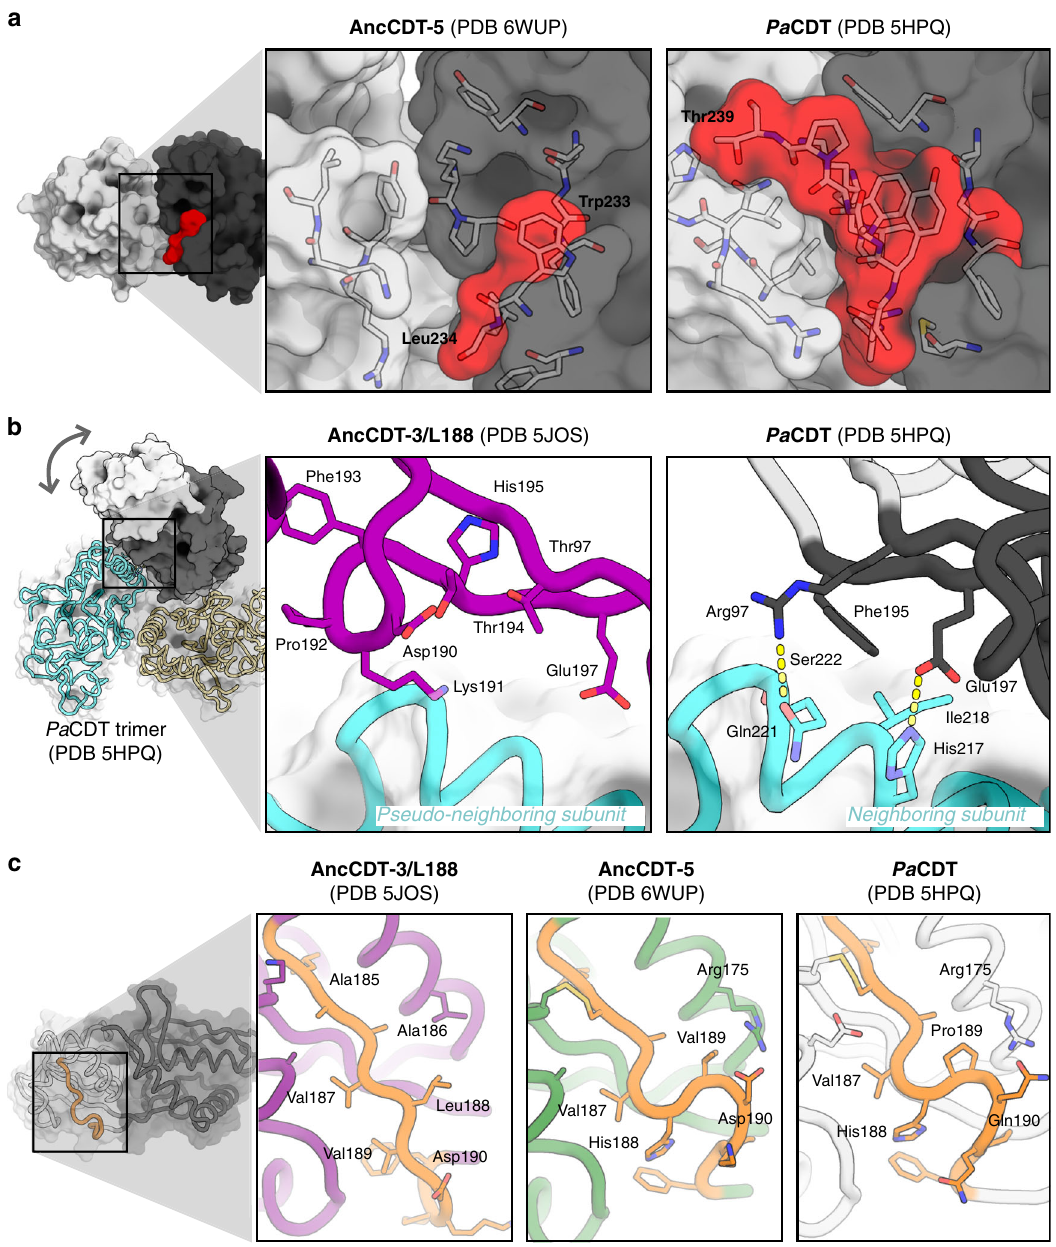
Fig. 5 Structural basis for the change in conformational sampling. a Comparison of the crystal structures of AncCDT-5 (left) and Pa CDT (5HPQ, right) highlight how the C-terminal extension (residues beyond 232 are highlighted in red) in Pa CDT facilitates additional interactions between the small (white) and large (grey) domains. b Pa CDT is a trimer in solution, and analysis of the crystal structures of Pa CDT (e.g., 5HPQ, shown here) reveals several interactions between the hinge region of chain A with the large domain of chain B that are likely to prevent the wide-open conformation from being sampled. These include packing of Phe195 against the neighbouring subunit, and polar interactions between neighbouring residues. Overlay of the crystal structure of AncCDT-3/L188 (purple, PDB 5JOS) further highlights how the wide-open state is likely to be incompatible with the trimeric arrangement of Pa CDT. c The fl exibility of the hinge region is known to control the open/closed dynamics of SBPs. Sequence and structural comparison of these regions in AncCDT-3/L188 (purple, PDB 5JOS), AncCDT-5 (green, PDB 6WUP) and Pa CDT (white, PDB 5HPQ) highlight that this is an intrinsically fl exible region, which is likely affected by